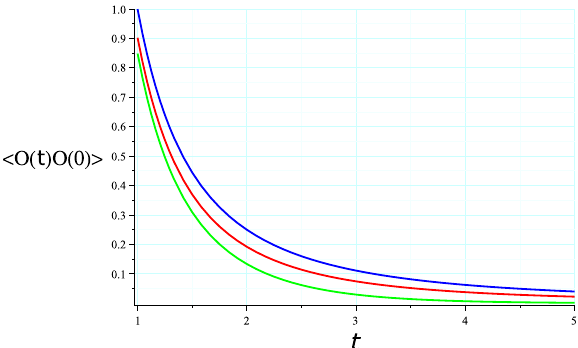
Figure 8 . Two-point correlator for a (cid:12)eld with ‘ = 1 and C = 1 = 2. Blue: Poincar(cid:19)e background p f ( t ) = t . Green: eternal black hole f ( t ) = tanh E 0 t . Red: evaporating black hole f ( t ) =